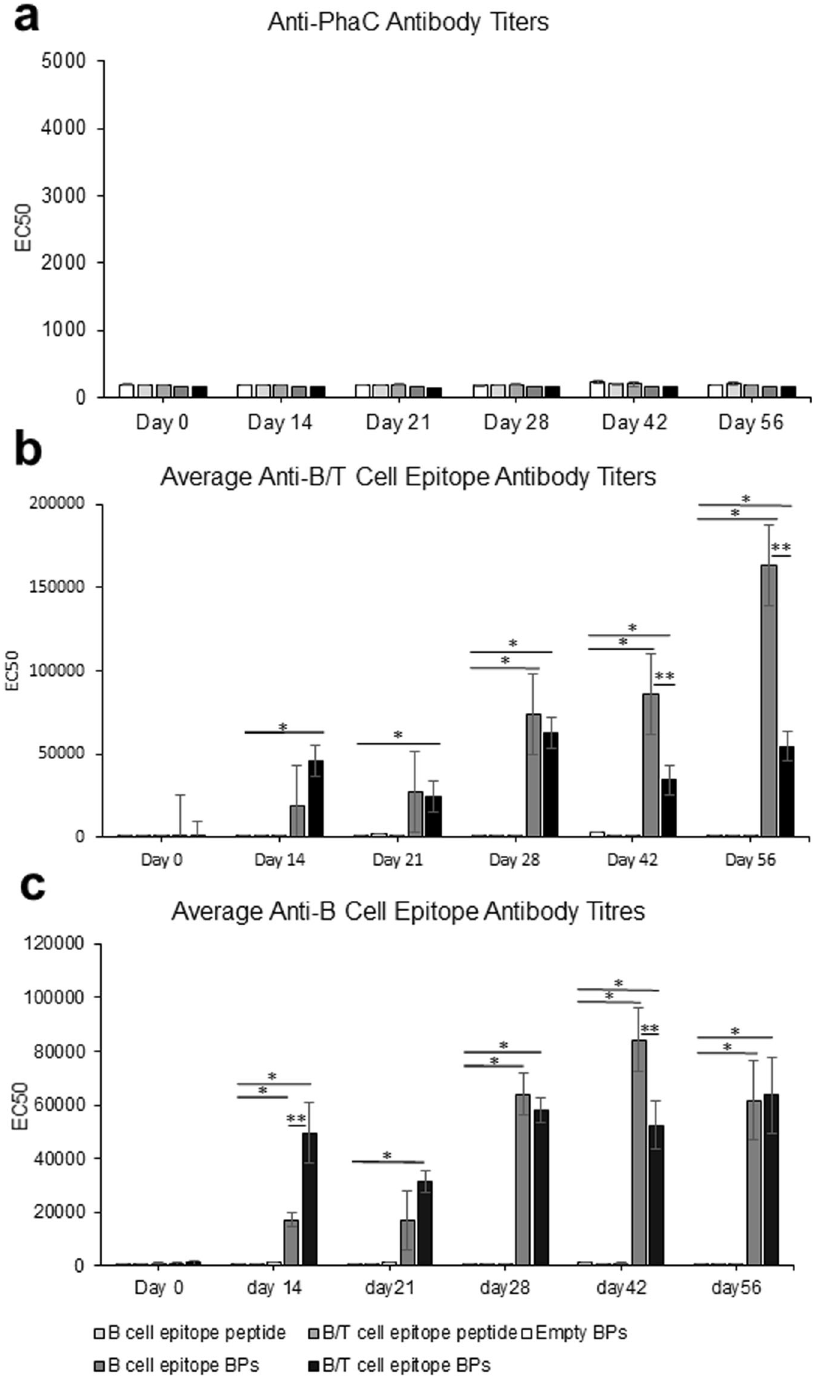
Fig. 3 Antibody responses presented as EC50 values determined by ELISA. Sheep immunised with either empty BPs indicated by white, B-cell epitope peptide indicated by light grey, B/T-cell epitope peptide indicated by grey, B-cell epitope-coated BPs indicated by dark grey and B/T-cell epitope- coated BPs indicated by black. Statistical signi fi cance was determined by Nonparametric Mann – Whitney (Minitab 19) when p < 0.05. * indicates statistical signi fi cance compared to empty BPs and epitope peptides. ** indicates statistical signi fi cance between B- and B/T-cell epitope-coated BPs. Eight individual sheep serum samples per group were analysed as each three technical replicates. a shows antibody titre representing binding to empty BPs quanti fi ed by ELISA. b shows antibody titre representing binding to B-cell epitope-coated BPs quanti fi ed by ELISA. c shows antibody titre representing binding to B/T-cell epitope-coated BPs quanti fi ed by ELISA. All data are mean and error bars represent + / –